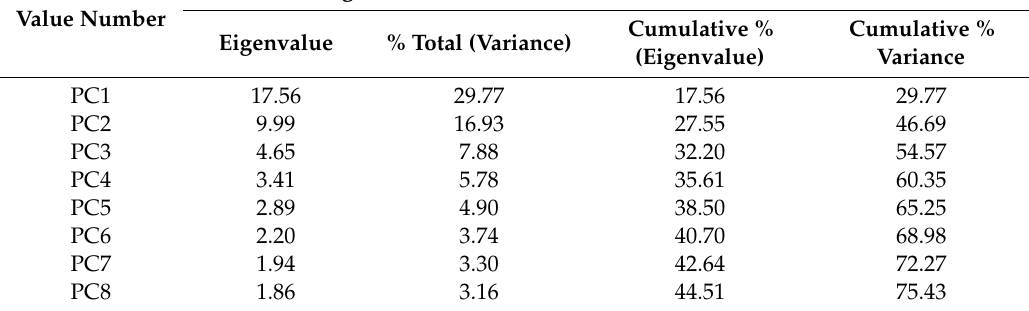
Table 2. Principal component loading, eigenvalues, % variance explained, and cumulative % variance for PC1 to PC8.